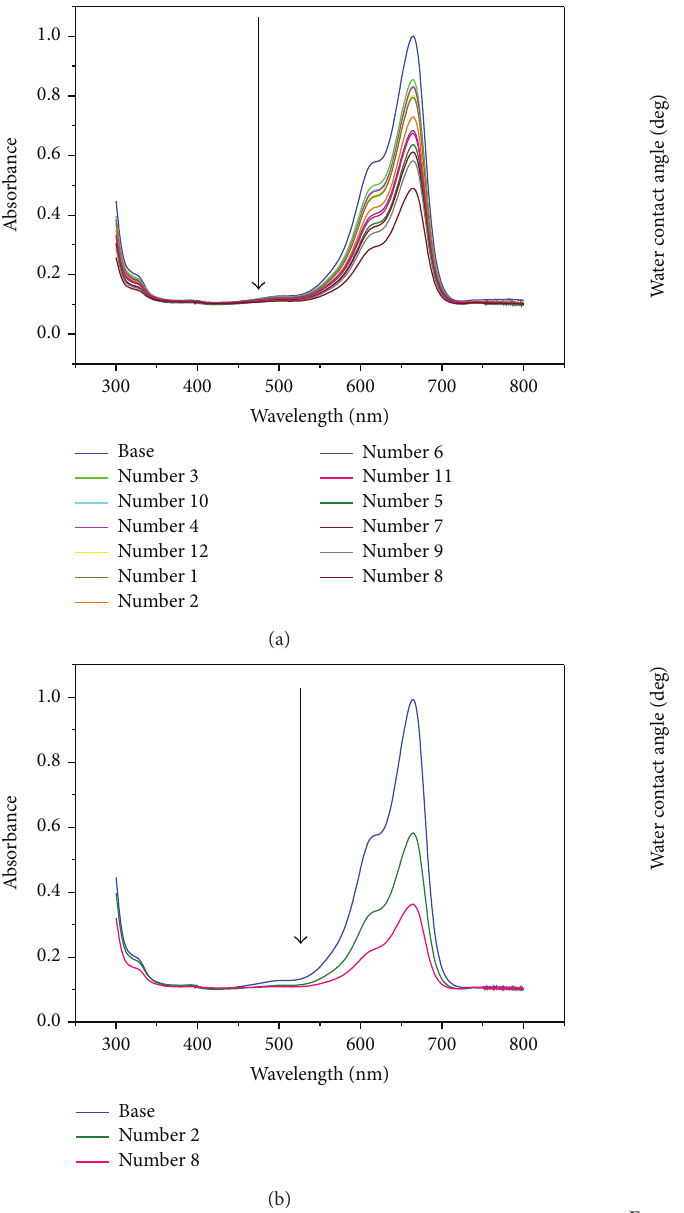
Figure 3: The absorption spectrum for MB aqueous solution (10 𝜇 M, pH = 7.0), after UV irradiation for 4h: (a) samples 1–12 and (b) samples number 2 and number 8.